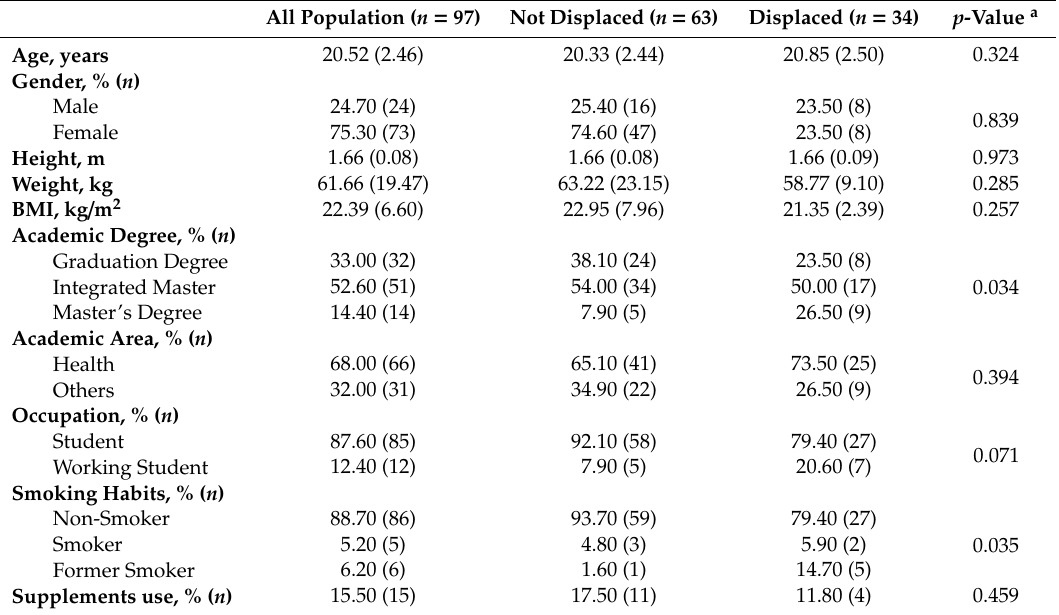
Table 1. General characteristics of the study population according to whether the university students are displaced from home or